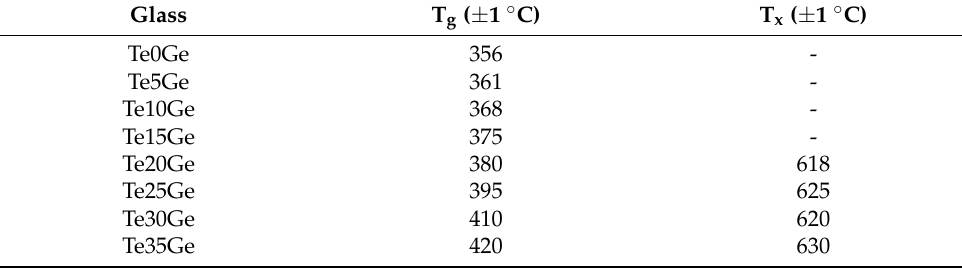
Table 1. The studied samples’ glass transition (T g ) and crystalization (T x )